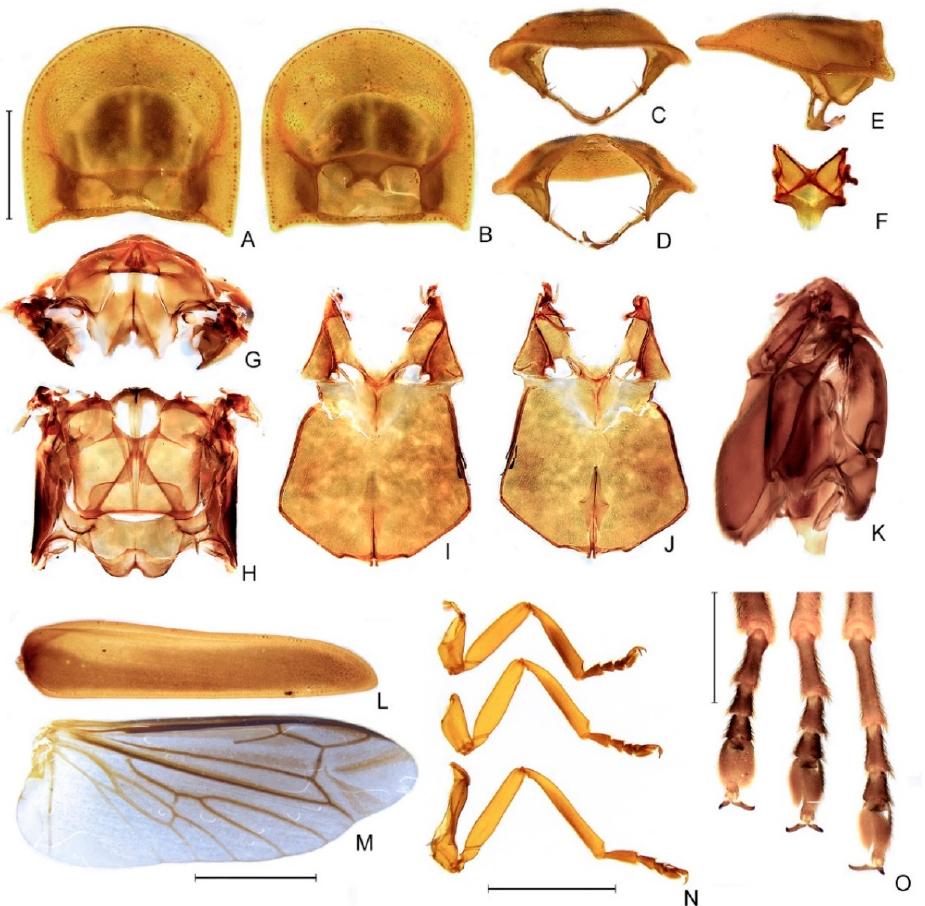
Figure 5. Zoiudo rosae sp. nov., thorax. ( A – E ) Pronotum: ( A ) dorsal, ( B ) ventral, ( C ) frontal, ( D ) pos- terior, ( E ) lateral. ( F ) Metascutellum, dorsal. ( G ) Metanotum, anterior. ( H ) Metanotum, dorsal. ( I – K ) Pterothorax: ( I ) ventral, ( J ) dorsal, ( K ) lateral. ( L ) Right elytron, dorsal. ( M ) Right wing, dorsal. ( N ) Pro-, meso-, and metaleg, from top to bottom, respectively. ( O ) Pro-, meso- and metatarsus, from left to right, ventral. Scale bar: A–K: 2